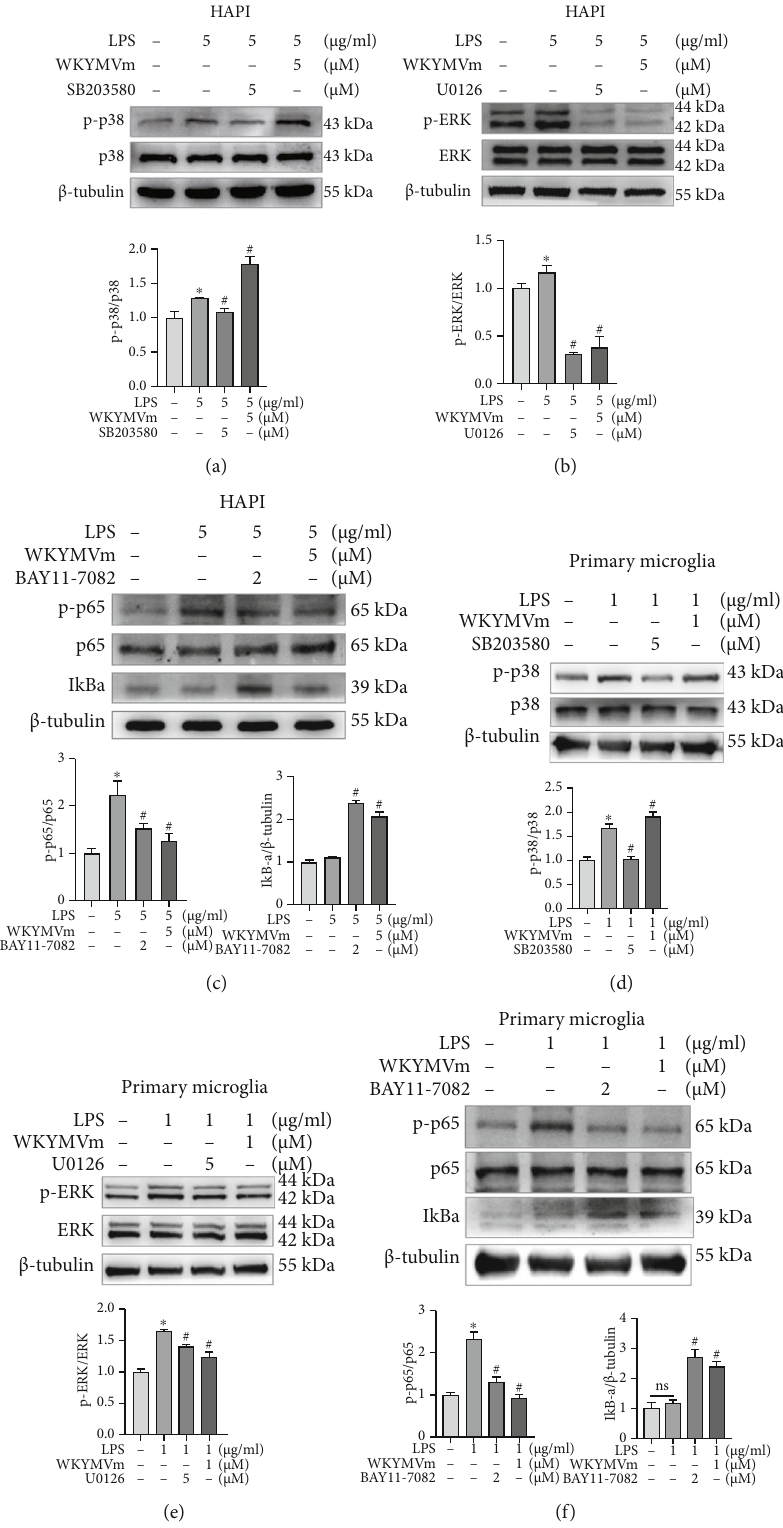
Figure 5: WKYMVm inhibited the ERK1/2 and NF- κ B p65 signaling pathways and a ff ected the p38 signaling pathway in microglial cells. (a – c) Western blot analyses and quantitative data. The impact of FPR2 activation by WKYMVm on phosphorylation of p38, ERK1/2, NF- κ B p65, and I κ B α protein level in LPS-treated HAPI microglia with or without pretreatment of WKYMVm. (d – f) Western blot analyses and quantitative data for p-p38, p-ERK1/2, p-NF- κ B p65, and I κ B α from each group in primary microglia. SB203580: p38-speci fi c inhibitor; U0126: ERK-speci fi c inhibitor; BAY11-7082: NF- κ B p65-speci fi c inhibitor. ∗ p < 0 : 05 vs. the control group; # p < 0 : 05 vs. the LPS